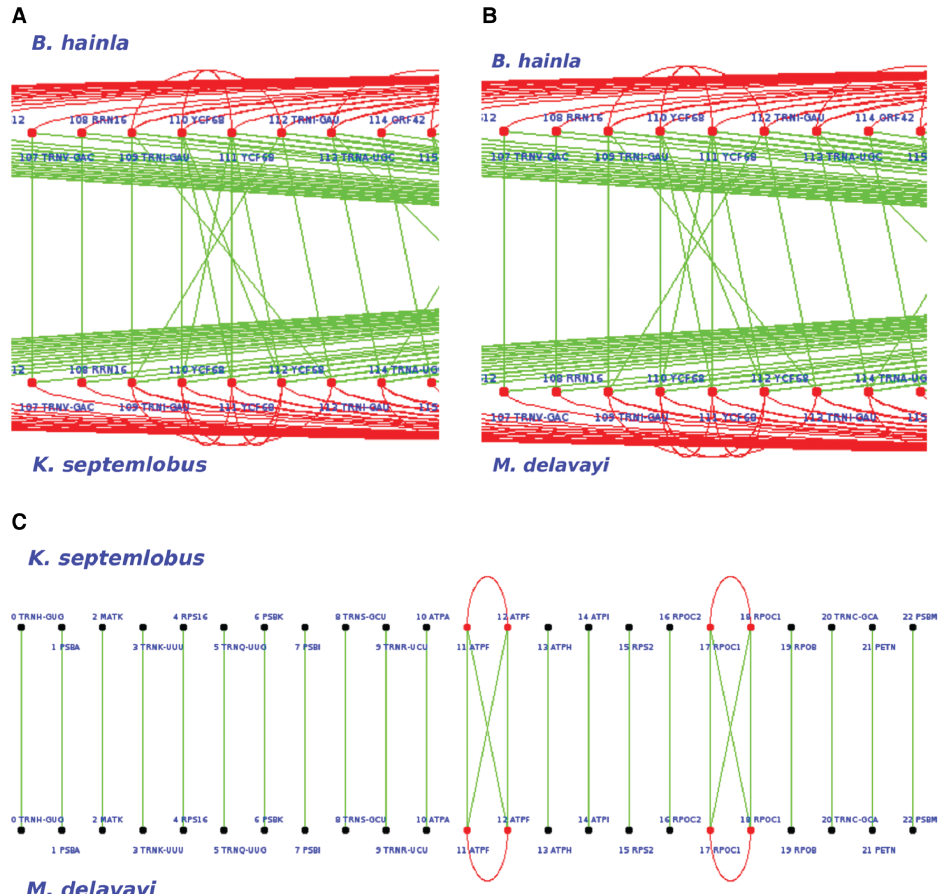
Figure 5: Graphical presentation of genes alignment between two genomes, useful in the naked eye investigation. Red curves indicate duplicated genes within a genome, while green lines indicate homology (same gene) between two distinct genomes. (A) At this particular location of the genome, a gene loss can be seen in B. hainla (or one gene gain in K. septemlobus ), namely the YCF69. (B) As the same situation occurs between B. hainla and M. delavayi , we can conclude to a gene loss (as gaining twice the same gene at the same location is less likely). (C) At this location, the gene order is not modified between the genomes of the two considered sister species, namely K. septemlobus and M. delavayi